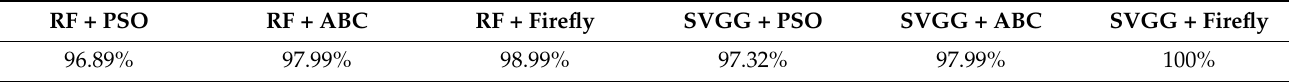
Table 5. Success Rates of Different Combinations When Evaluating the 299 TestSsamples. RF + PSO RF + ABC RF + Firefly SVGG + PSO SVGG + ABC SVGG + Firefly 96.89% 97.99% 98.99% 97.32% 97.99%